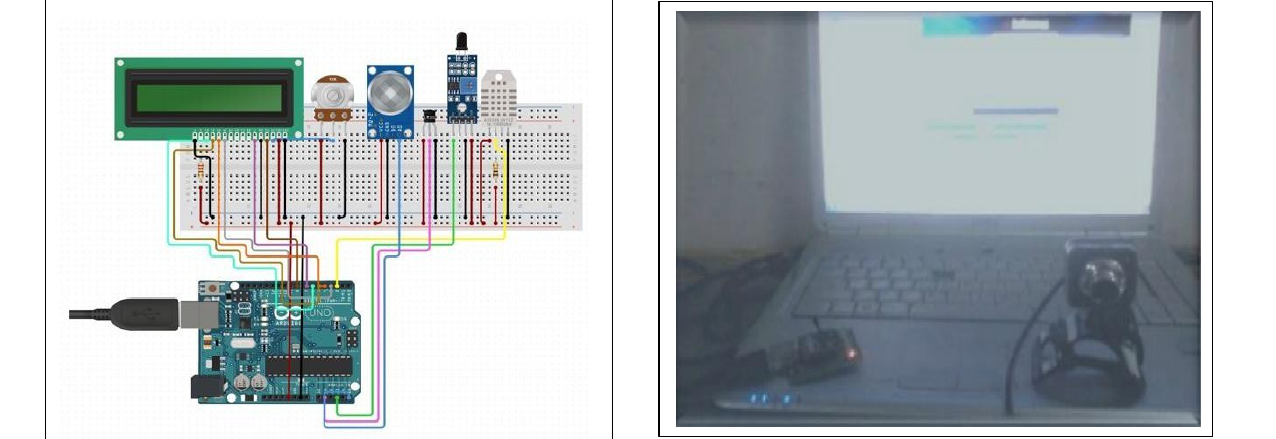
Fig. 4 : Circuit Diagram of Coal Mine-Side Monitoring System.